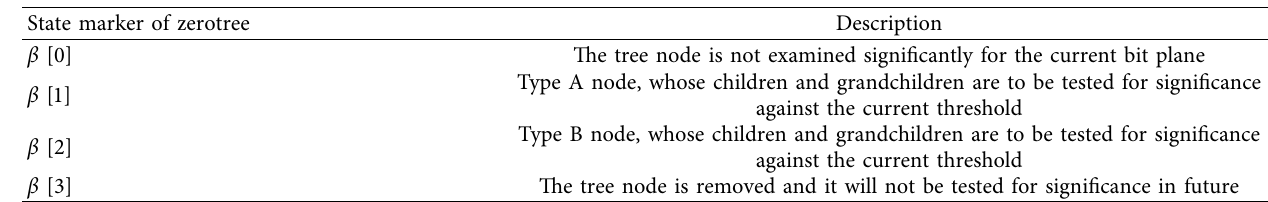
Table 2: Detail description of the state marker for trees “ β